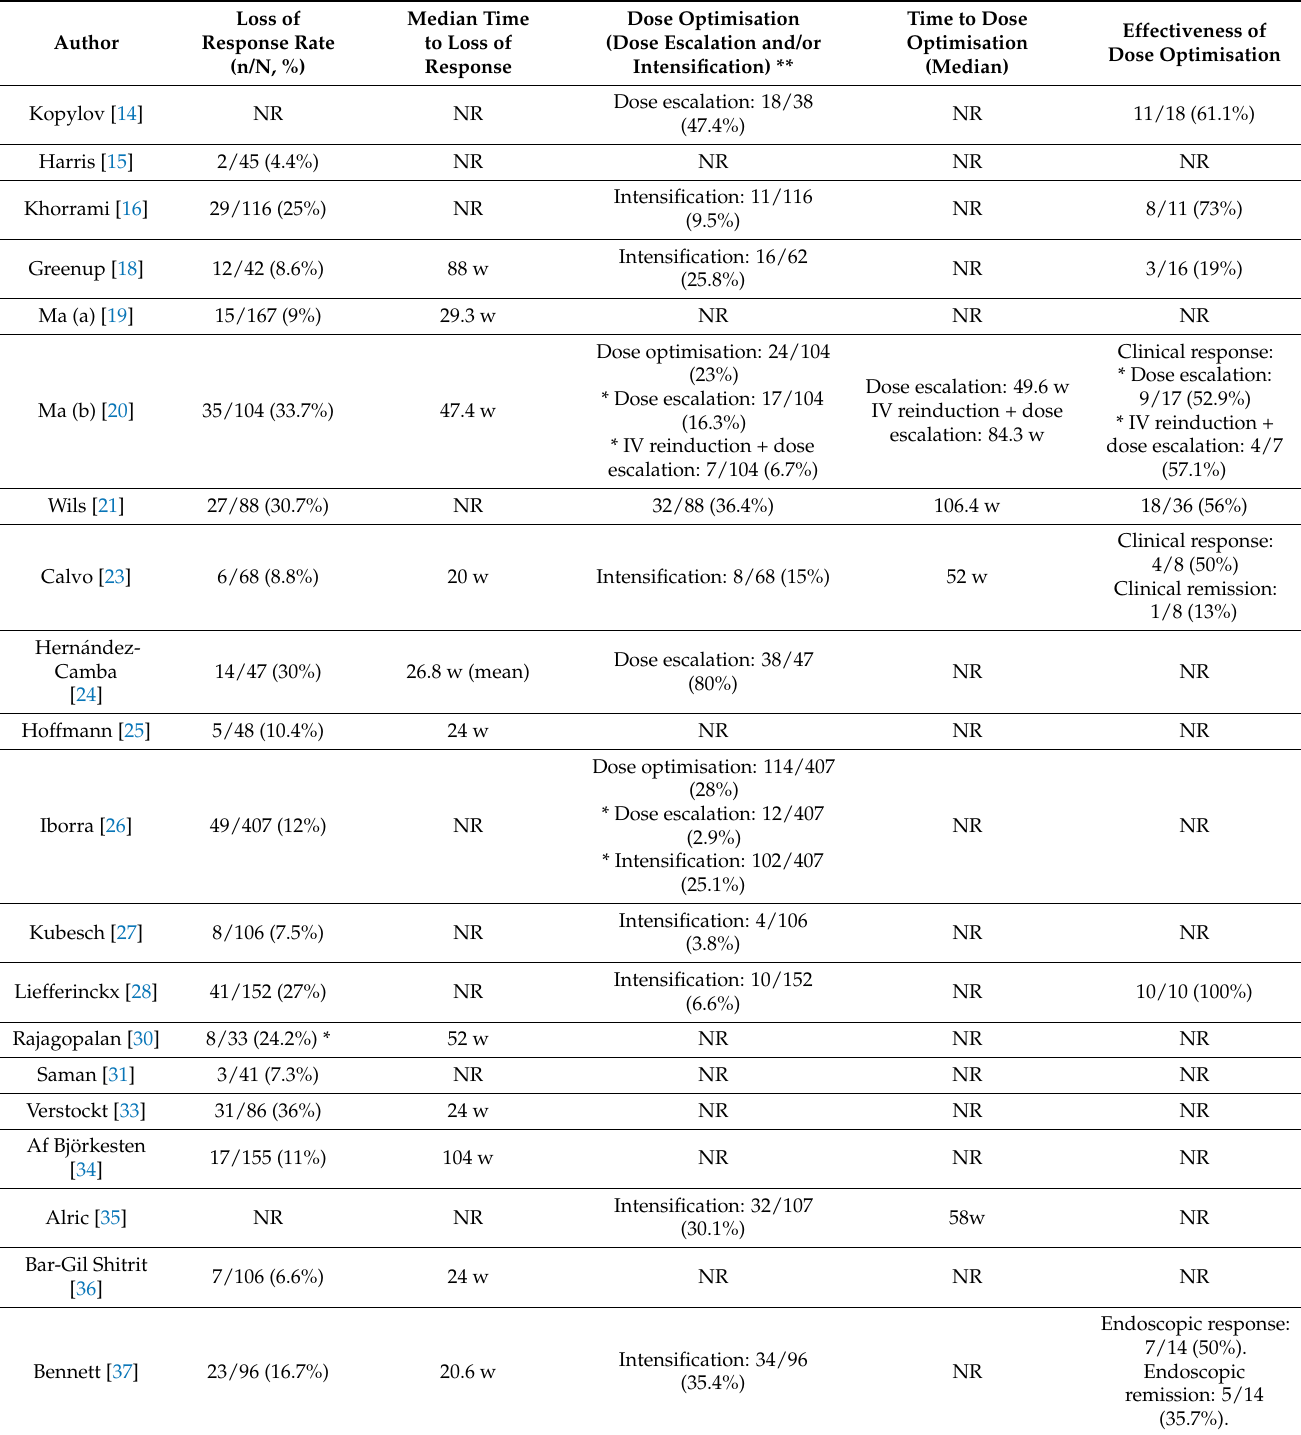
Table 3. Loss of response to ustekinumab and frequency and effectiveness of ustekinumab dose